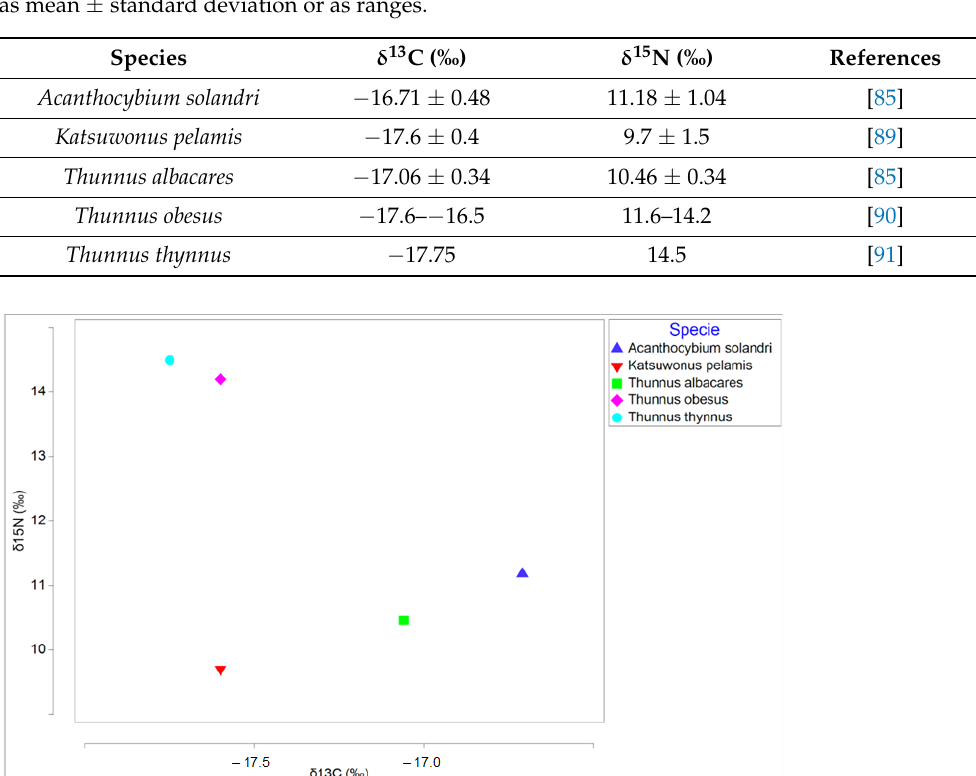
Figure 3. Graph showing trophic relationships taken from studies in the